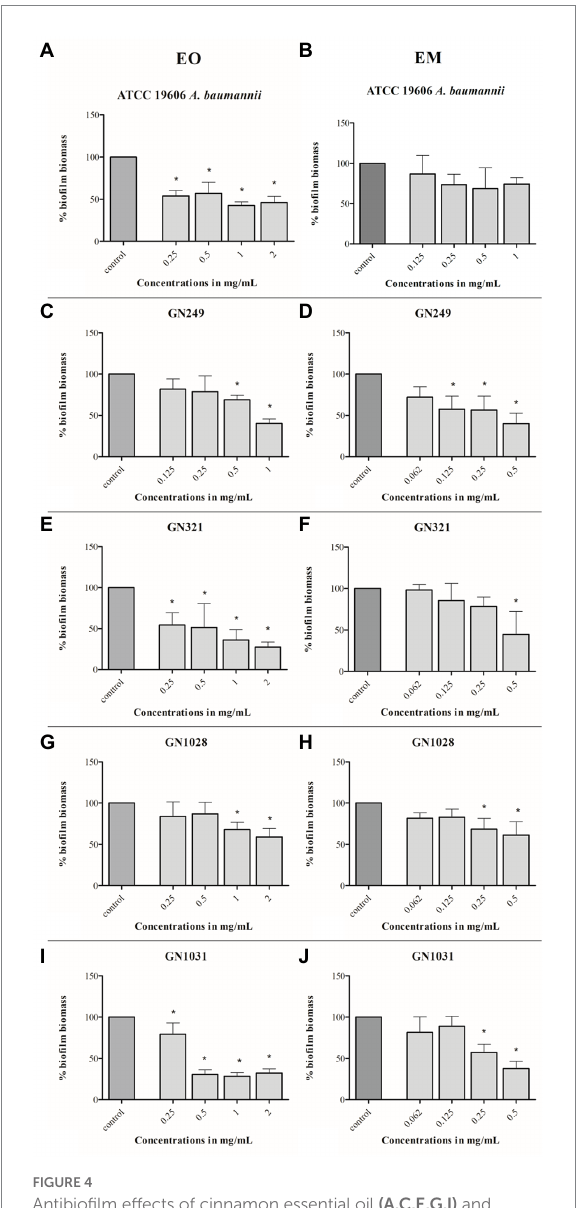
FIGURE 4 Antibiofilm effects of cinnamon essential oil (A,C,E,G,I) and cinnamon emulsion (B,D,F,H,J) on Acinetobacter baumannii strains. The share of pure cinnamon essential oil in emulsion was 20% v / v . The range of minimal inhibitory concentration values for cinnamon essential oil were from 0.25 to 0.5 mg/ml and for cinnamon emulsion from 0.125 to 0.25 mg/ml. The experiment was done three times in hexaplicates. Statistical significance was * p < 0.05.